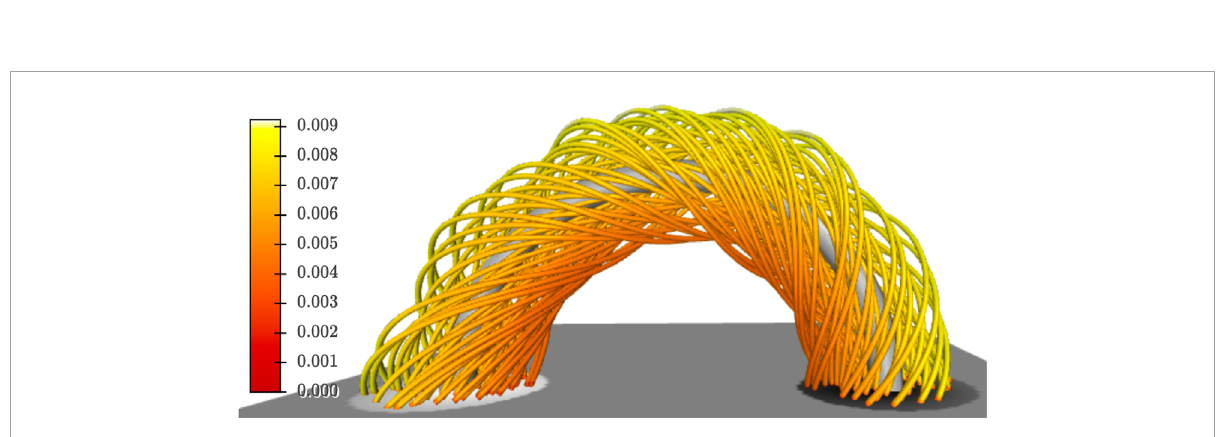
FIGURE 4 Output from the visualisation notebook. The axis is shown by a thicker grey line while the other field lines are shown by thinner lines coloured based on their local contribution to the total T g integral. B z at the lower boundary of the domain is also